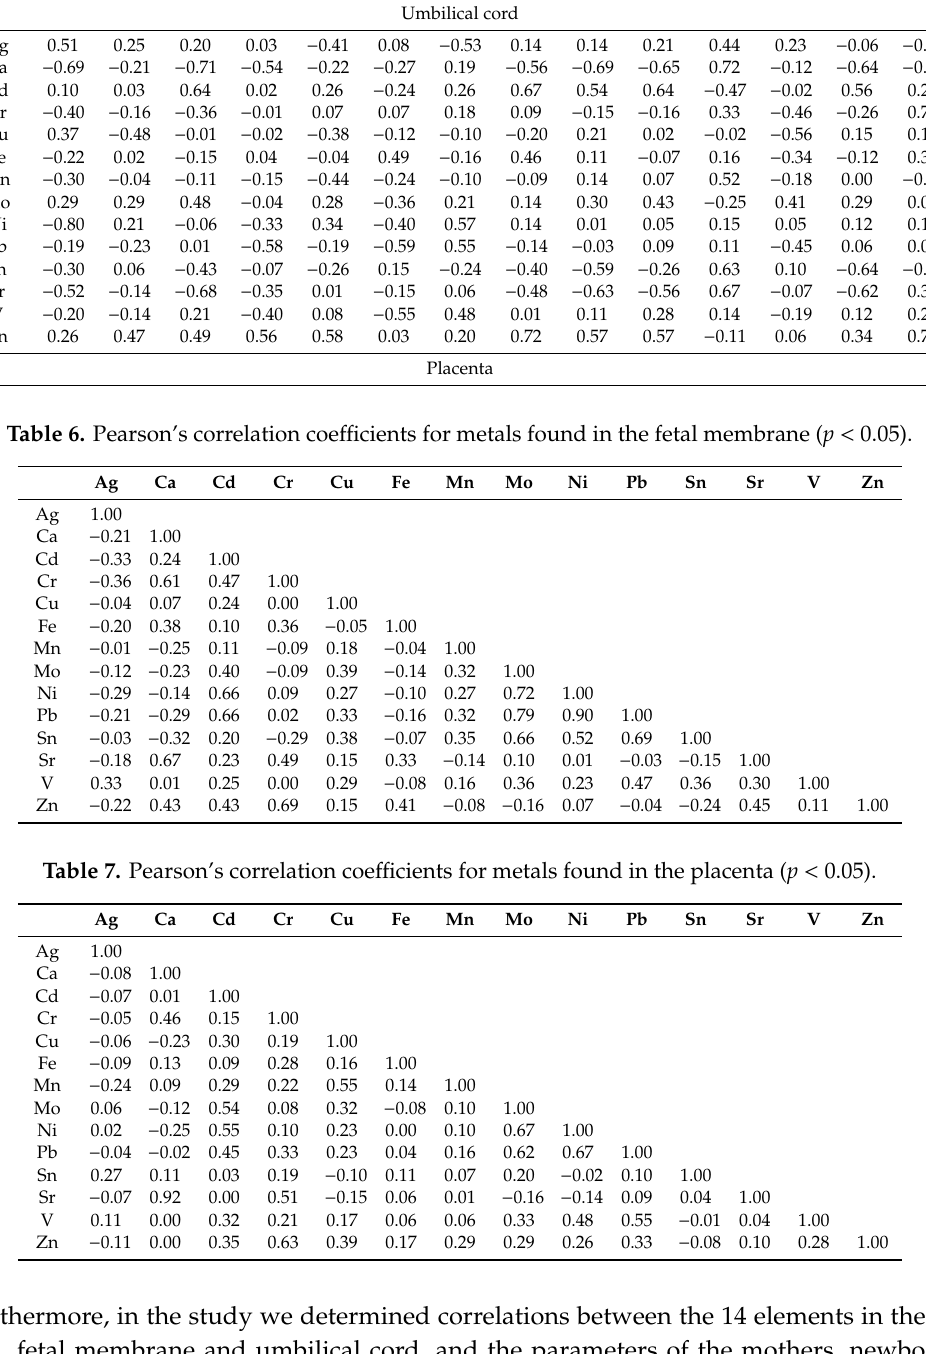
Table 5. Pearson’s correlation coe ffi cients between analyzed elements in the umbilical cord and placenta ( p < 0.05). Ag Ca Cd Cr Cu Mn Mo Ag − 0.40 − 0.16 − 0.36 − 0.01